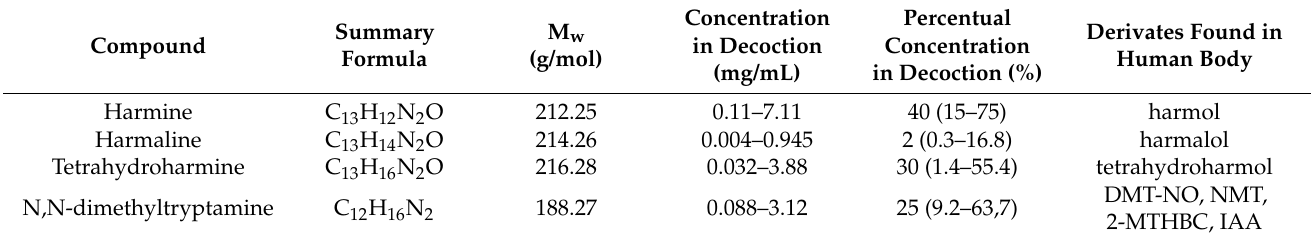
Table 1. Psychedelic DMT and β -carbolines and their metabolites as components found in traditional Ayahuasca and in the human body. The data in the table are collected from the literature [19,29,33].